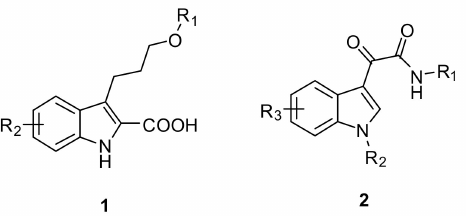
Figure 1. Chemical structures of indole-derived compounds with in vitro anticancer activity: Mcl-1 inhibitors ( 1 ) and tubulin inhibitors ( 2 ).